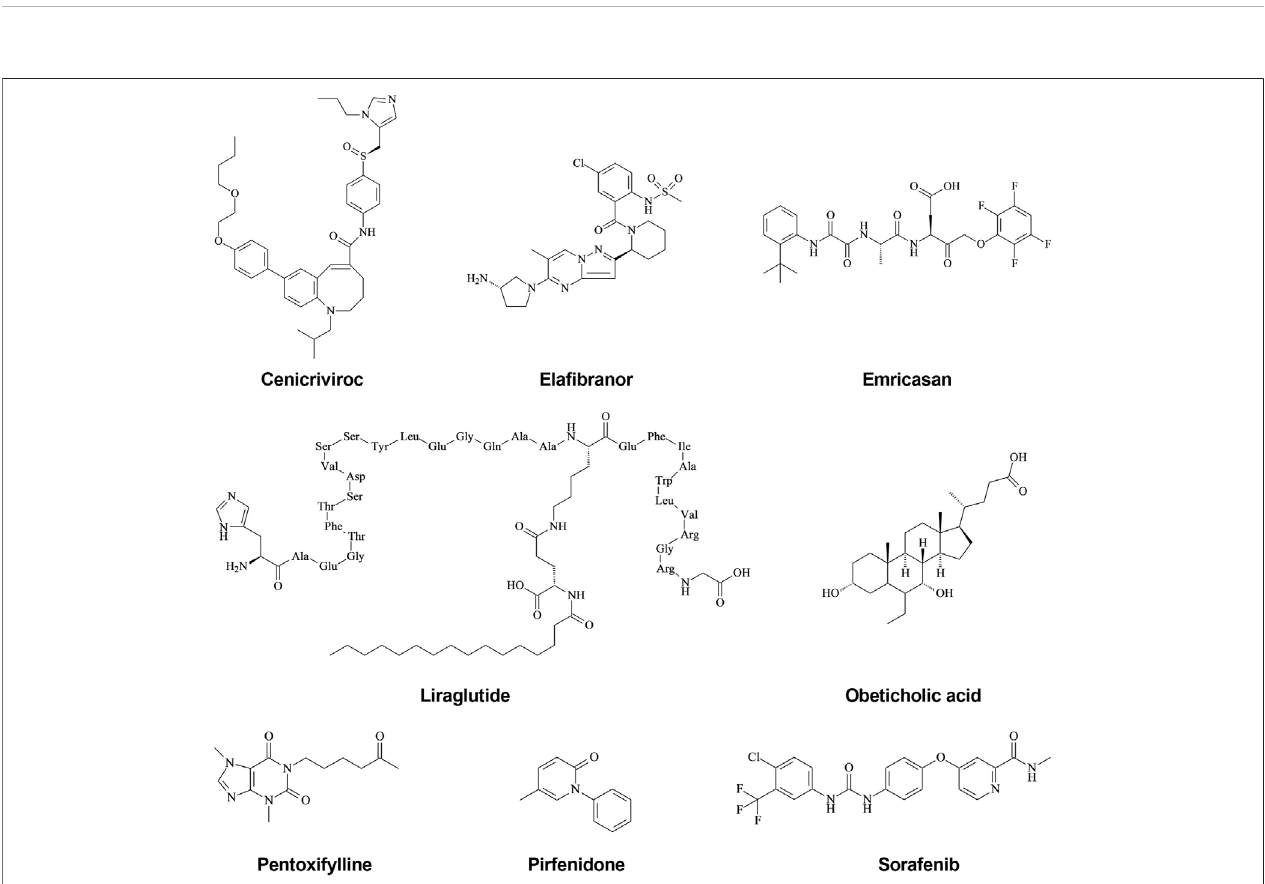
FIGURE1| Structuralformulaofnewdrugswithanti-hepatic fi brosiseffects.(1)CenicrivirocisadualantagonistofCCR2/5,whichalsoinhibitsbothHIV-1andHIV- 2, and displays potent anti-hepatic fi brosis activity. (2) Ela fi branor is a double agonist of PPAR α / δ , and both animal experiments and clinical trials have found that it has anti-hepatic fi brosis activity. (3) Emricasan is an irreversible pan-caspase inhibitor, which is currently in a phase 2 clinical trial to test its ef fi cacy in treating liver injury and fi brosis, although its clinical trial results are controversial. (4) Liraglutide is a GLP-1 receptor agonist used clinically to treat type 2 diabetes, which functions by ameliorating the progression of NAFLD in patients with T2DM. (5) Obeticholic acid is a potent, selective, and orally active FXR agonist; FXR has been shown to reduce in fl ammatory mediator expression in HSCs via the induction of PPAR γ , suggesting that FXR is an ideal target for the treatment of hepatic fi brosis. (6) Pentoxifylline is an orally active non-selective PDE inhibitor, with anti-in fl ammatory and anti-proliferation effects. PDE has a strong anti- fi brosis effect but needs more in-depth research. (7) Pirfenidonehasbroad-spectrumanti- fi brosiseffectsandisthe fi rstdrugtodemonstratesomeef fi cacyforIPF,whichwasapprovedbytheFDAin2008.Themechanism of action of Pirfenidone may be related to the reduction of TGF- β -induced signal transduction pathways. (8) Sorafenib is a multikinase inhibitor of Raf-1, B-Raf, and VEGFR-2,an inhibitor oftyrosine protein kinases thattargets theRaf/Mek/Erk pathway. Animalexperiments have shown that Sorafenib has anti- fi brosis effects, and the mechanism may be related to inhibiting the TGF- β 1/Smad3